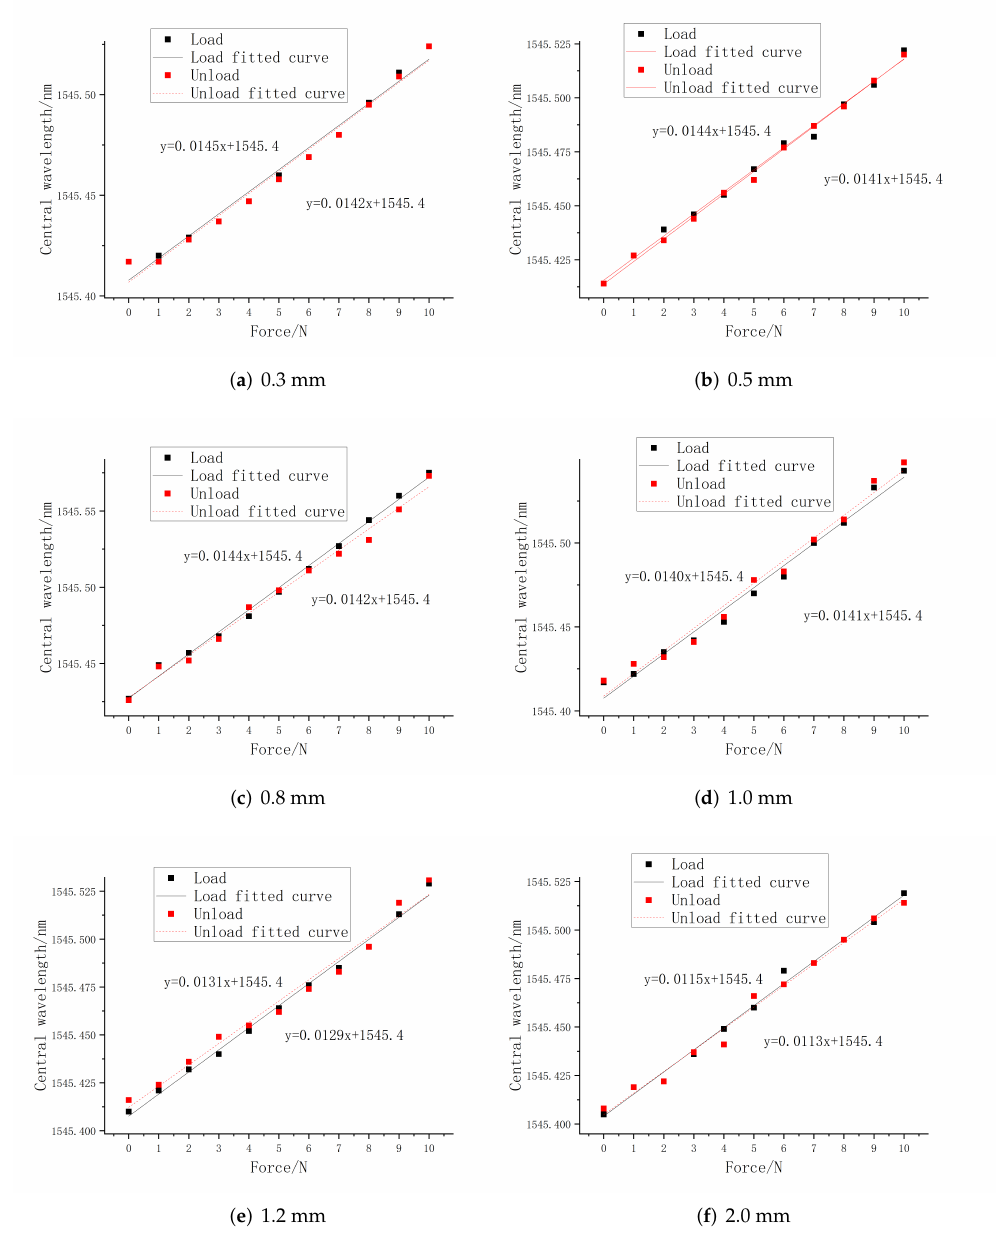
Figure 9. Loading and unloading fitting curve of